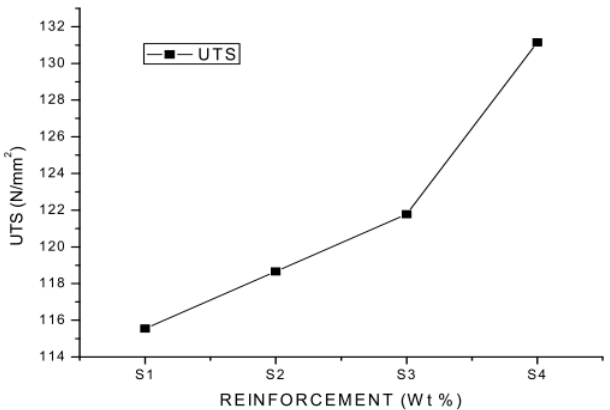
Figure 14. Tensile strength of Al7075–SiC–ZrO 2 composites [91]. Table 8. HAMC preparation ratio [91].